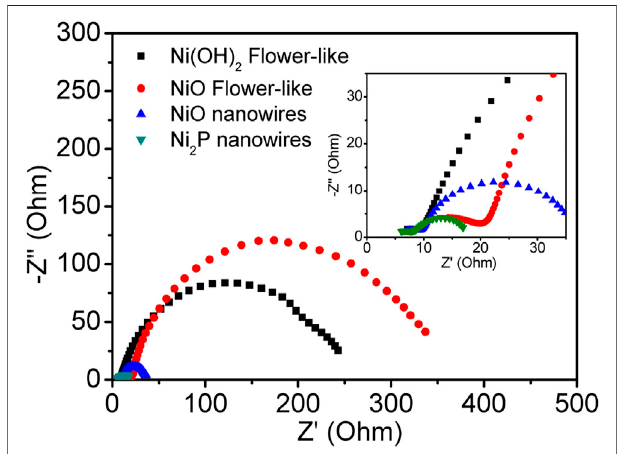
FIGURE 6 | Electrochemical impedance spectrum of Ni 2 P nanowires.